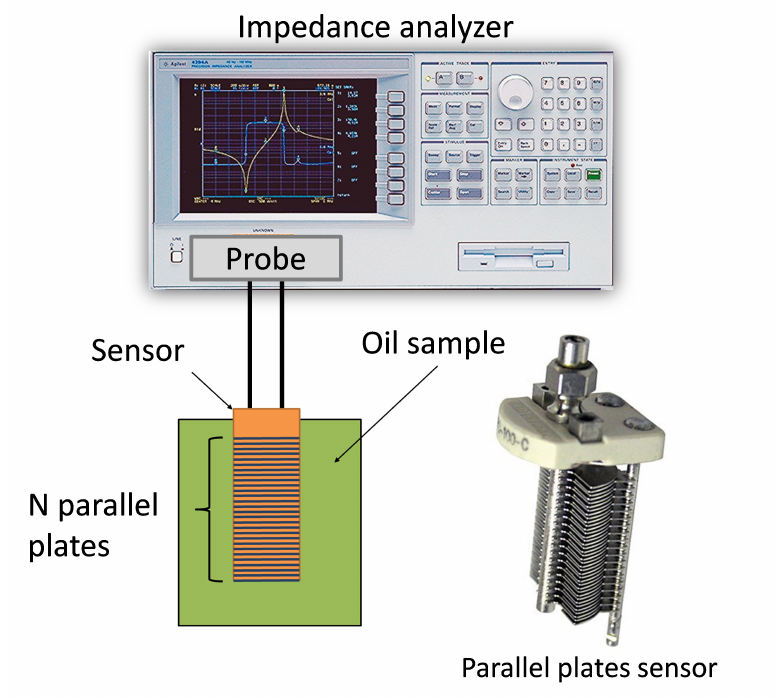
Figure 3. Measurement set-up for reference measurement including the parallel plates’